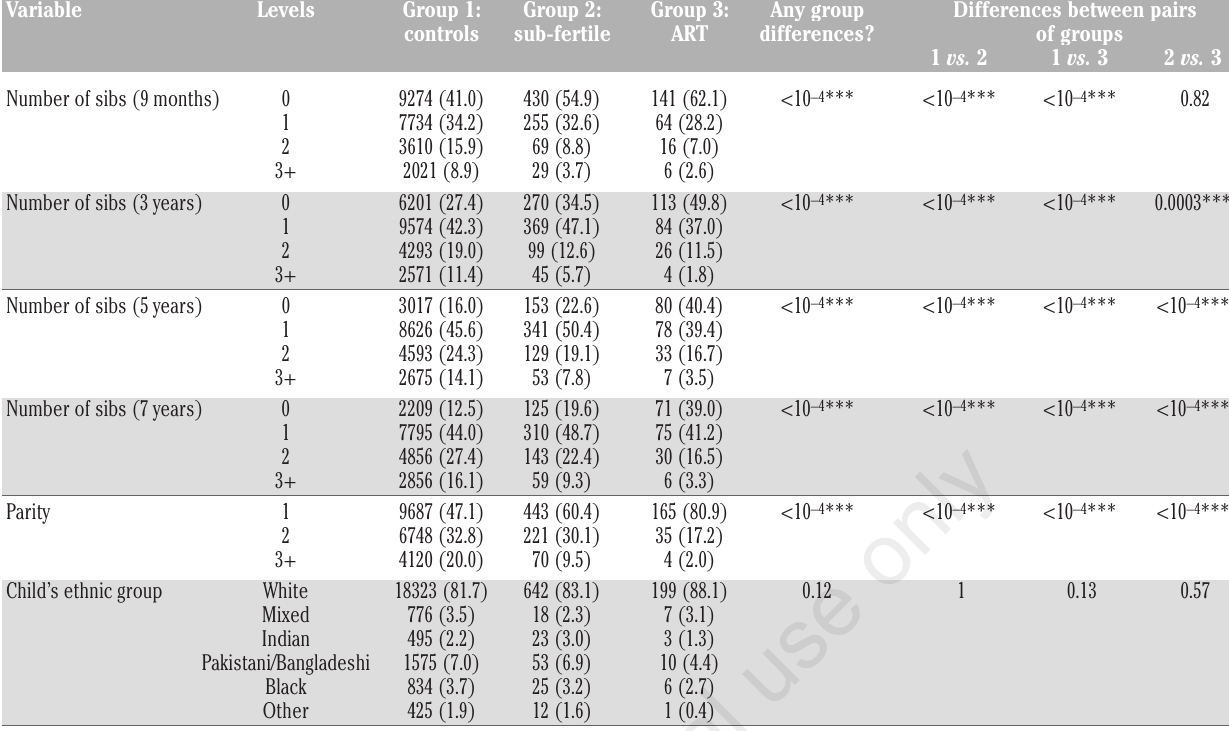
Table 2. Summary of comparisons of categorical covariates by group (I). Numbers of cases are given, with the percentage of the group this represents in brackets. The P for a chi-square test for group differences is given, along with the P for tests for differences between each pair of groups, using a Bonferroni correction to maintain the Type I error rate of 5%.